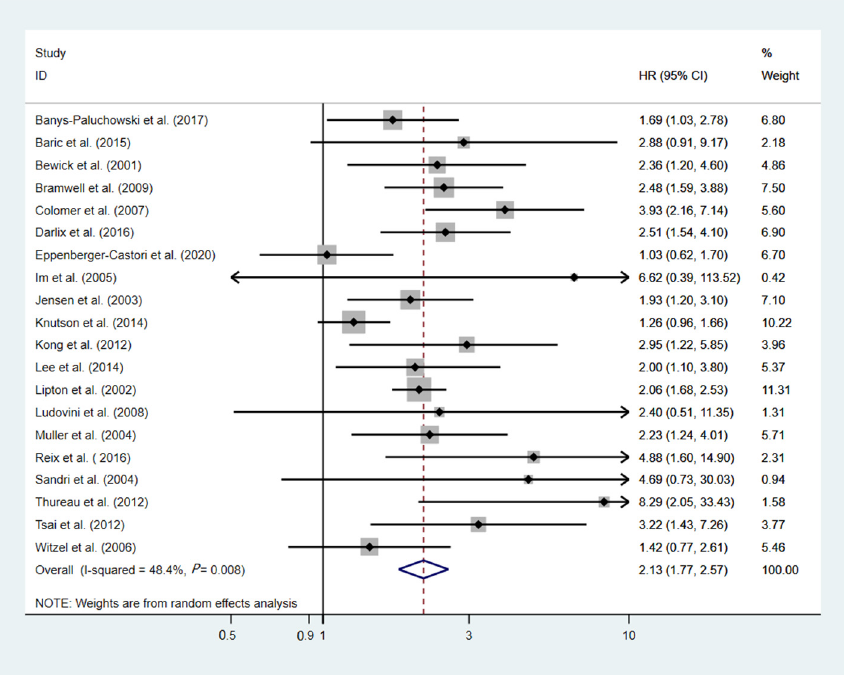
Figure 4. Forest plot of the HR for the OS from the eligible studies